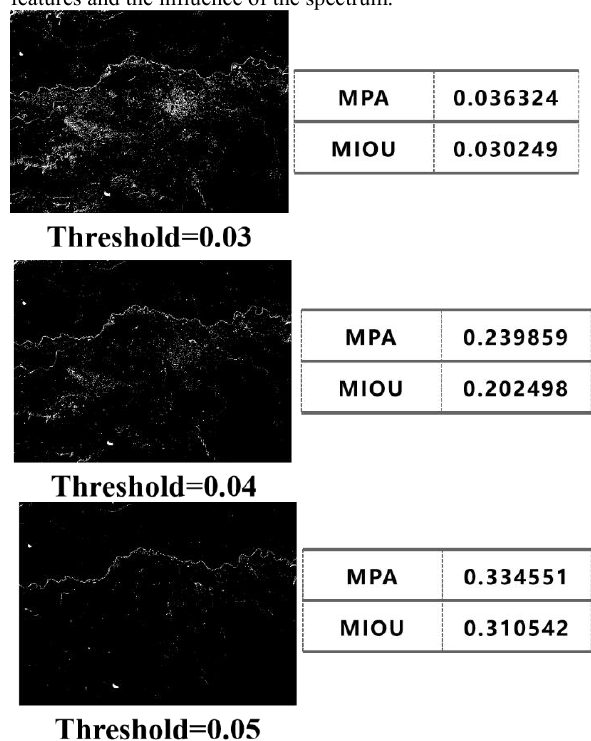
Fig.7. The results of different thresholds by NDWI